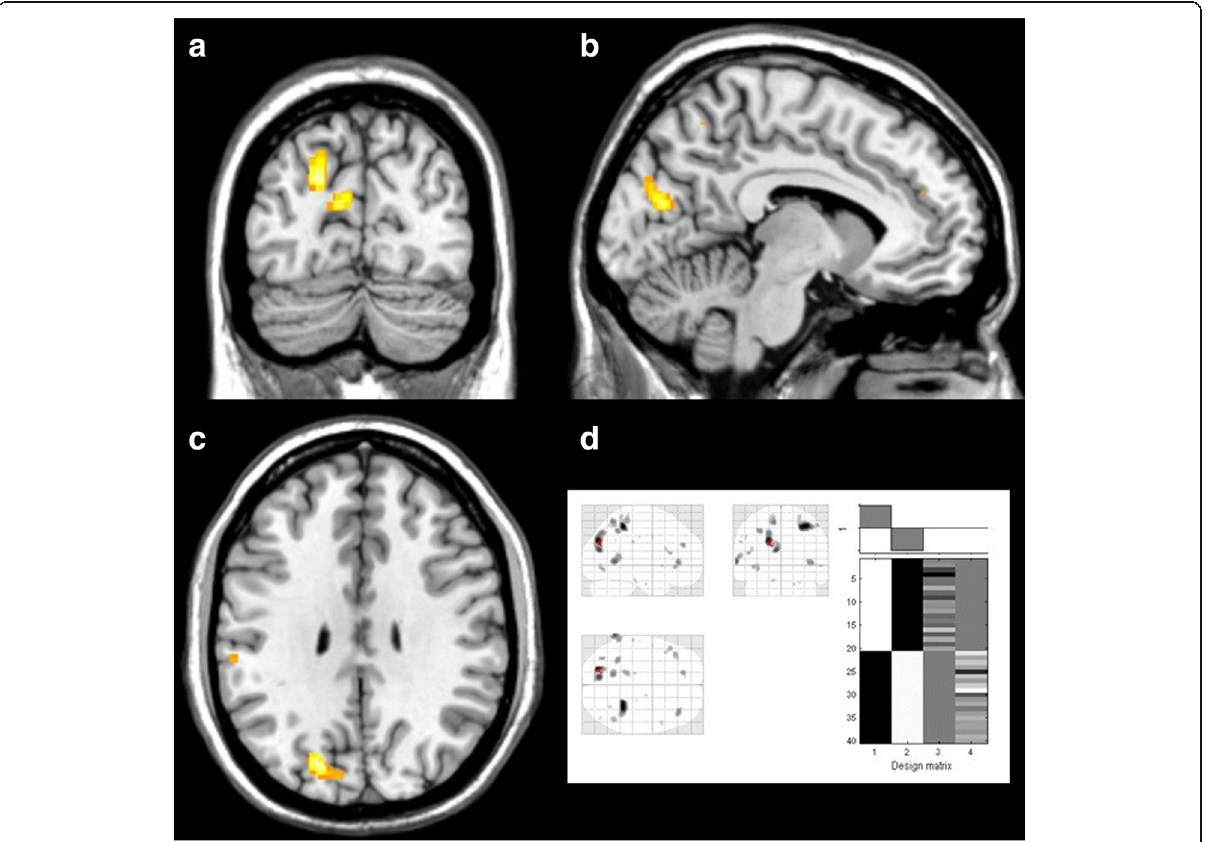
Fig. 2 Areas of increased metabolism in healthy controls compared with migraine patients using the interaction with area under the VEP as regressor. Clockwise from top left: ( a ) coronal view, ( b ) sagittal view, ( c ) axial view, and ( d ) “ glass brain ” representation and design